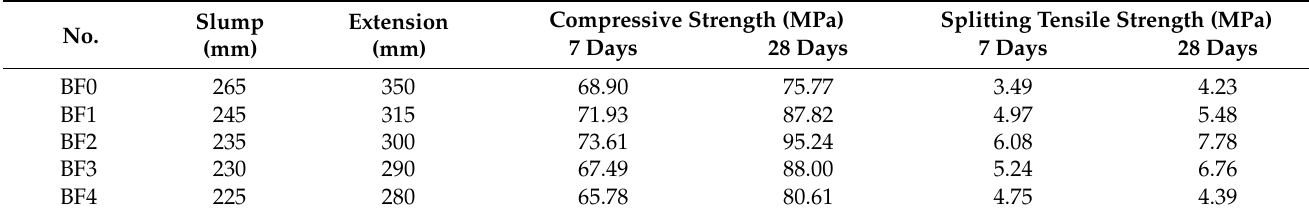
Table 3. Test results of slump, extension, and mechanical properties of